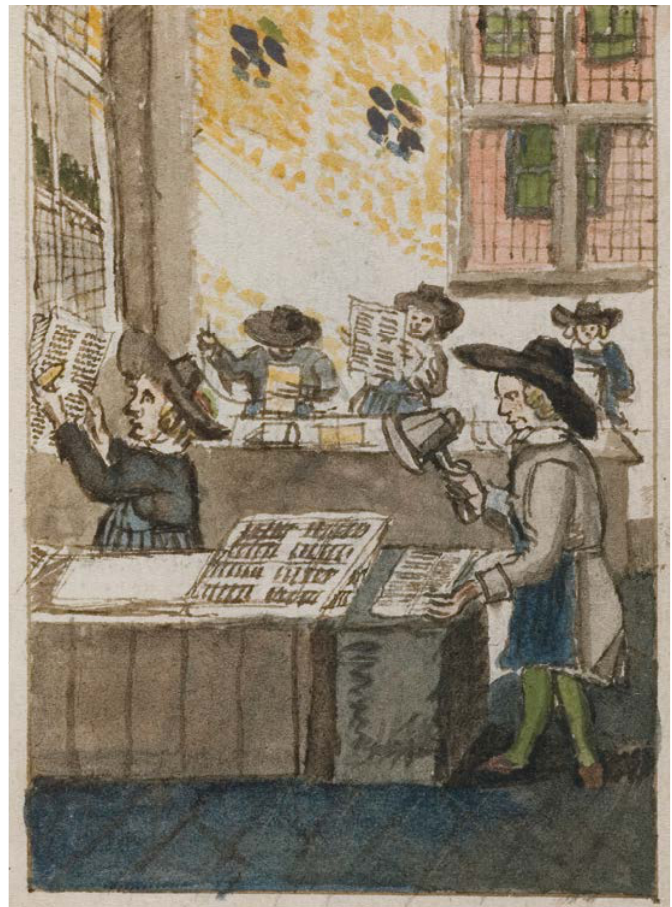
In the foreground, at the right, ignore the fellow with the big hammer. Focus instead on two workers at the left and at centre-rear, each in the process of making the fi rst fold on a sheet printed in-octavo by aligning its two halves with the help of sunlight shining through the win- dows on the left, as in Vermeer. Th e worker by the window holds a folder in his left hand, the one at the rear perhaps in his right. Because sheets of paper were then produced with deckle (and therefore irregular) edges, binders could not accurately fold a sheet simply by aligning its edges: they had rather, as de Bray states, to peer through a tentatively folded sheet and align the edges of a page of type printed on the front half of the sheet with the edges of a corresponding page of type on the back half, before they adjusted the fold as necessary and fi nally compressed it. Th is same deckle edge had already made it diffi cult for the printer to lay sheets square on the points on the tympan. (Th ese problems for printer and binder would not be solved until the start of the nineteenth century, when the Fourdrinier machine fi rst produced a web of ‘wove’ paper without deckle edges. Since then, a sheet cut from such a web would more simply be positioned for printing or folding just by its straight edges, without the need of points. Back now to